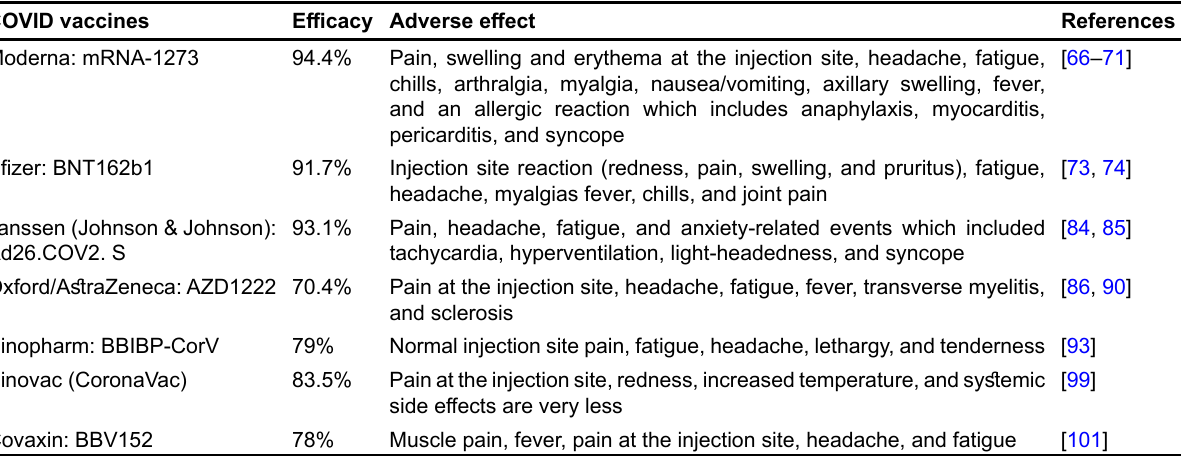
Table 1. List of vaccines and their efficacy and reported side effects COVID